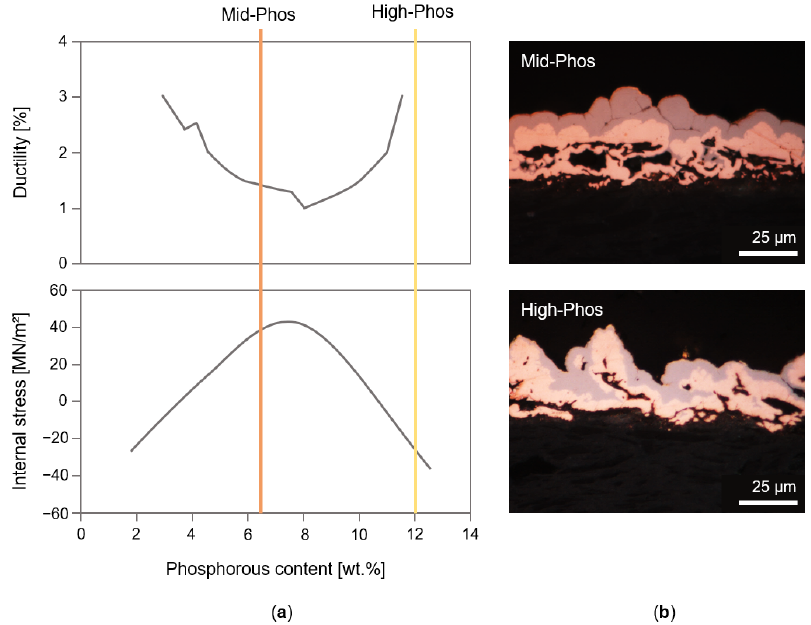
Figure 3. ( a ) Influence of the phosphorous content in electroless nickel on the ductility and internal stresses of the resulting metal layer, as adapted from Ref. [18]. The orange and yellow highlighted phosphorous contents, determined by EDX, were applied in this study; ( b ) Cross-section images of Cu/Ni/Au conductor tracks revealing cracks in the Mid-Phos nickel layer.